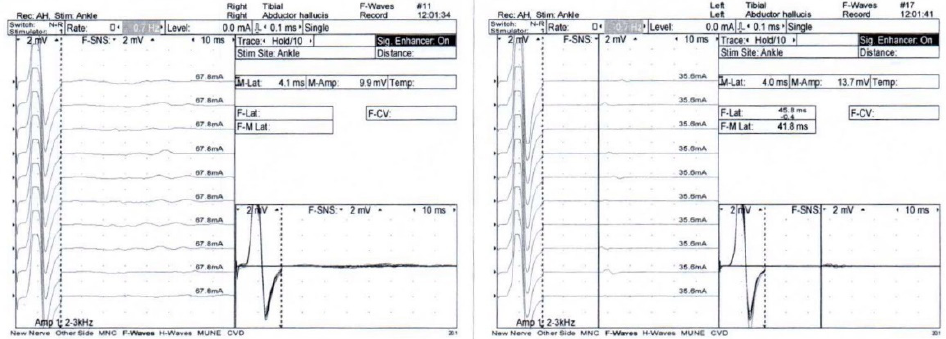
Figure 3. Absence of an F wave response of the right and left tibial nerves was demonstrated.